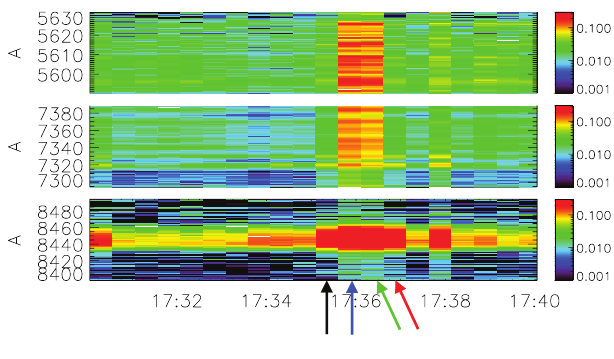
Fig. 7. SIF spectra for event 3. The molecular band emissions are seen during a time of high energy aurora at about 17:36 UT in panel O + (5620) (top panel) and panel O + (7319) (second panel). 2 The bottom panel (panel OI(8446)) confirms the detection of atomic oxygen in ASK3 during this event. The arrows indicate the times of the ASK images seen in Fig.